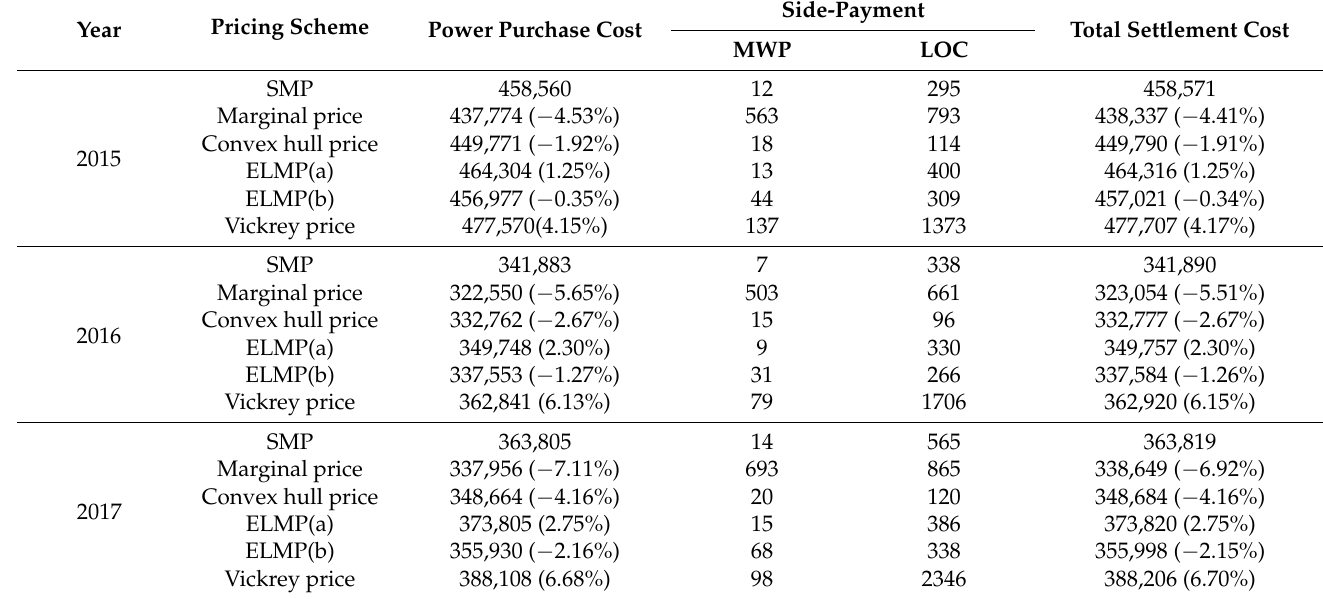
Table 4. Comparison of the settlement results by market price (hundred million